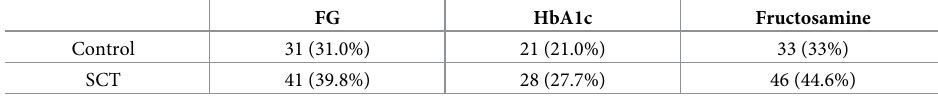
Table 3. Number of subjects classified as over the clinical cut-point for each biomarker of hyperglycemia. FG HbA1c Fructosamine Control 31 (31.0%) 21 (21.0%) 33 (33%) SCT 41 (39.8%) 28 (27.7%) 46 (44.6%) Clinical cut-points were set at 126 mg/dL for FG, 6.5% for HbA1c, and 260 μ mol for fructosamine. FG = Fasting Glucose; HbA1c = Glycated